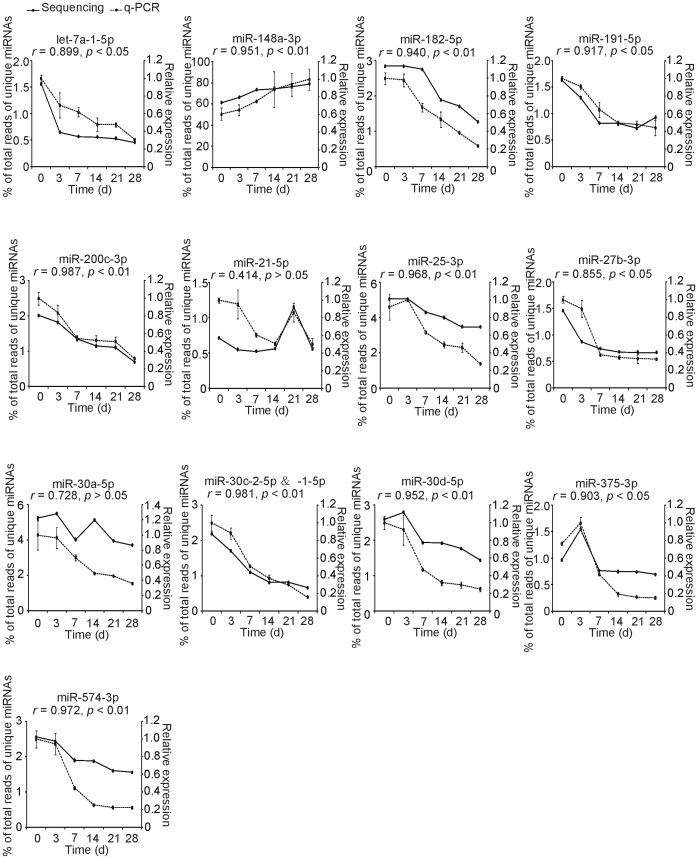
Lactation-related expression patterns of 13 abundant immune-related miRNAs.The data are normally distributed (Kolmogorov-Smirnov test, p>0.05). Pearson correlation was used to determine the relation of miRNAs expression changes between the q-PCR and the deep sequencing approaches. Values are means±SD.